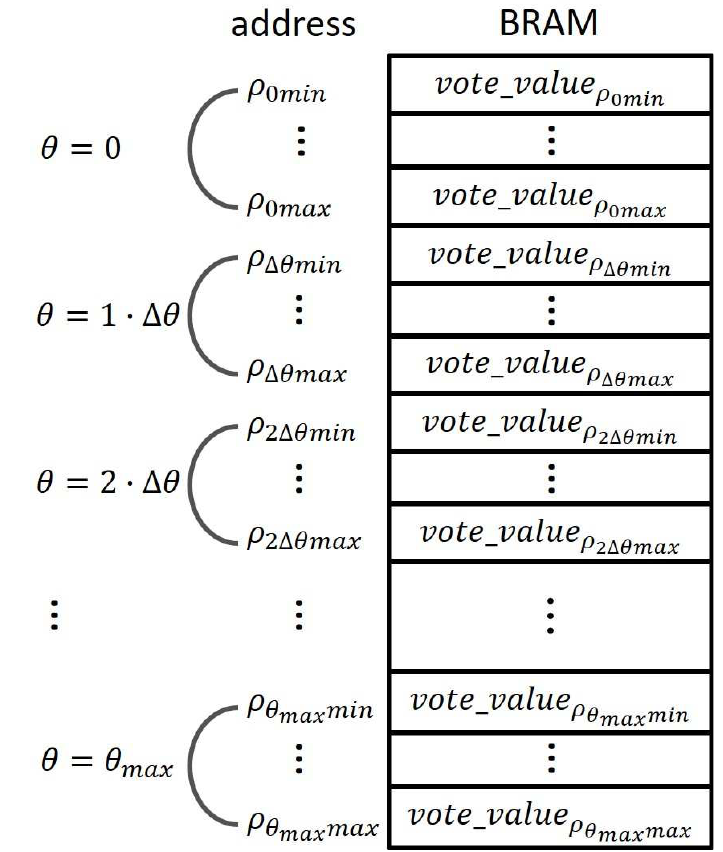
Figure 4. Mapping of 2-dimensional Hough space with ( ρ , θ ) into 1-dimensional